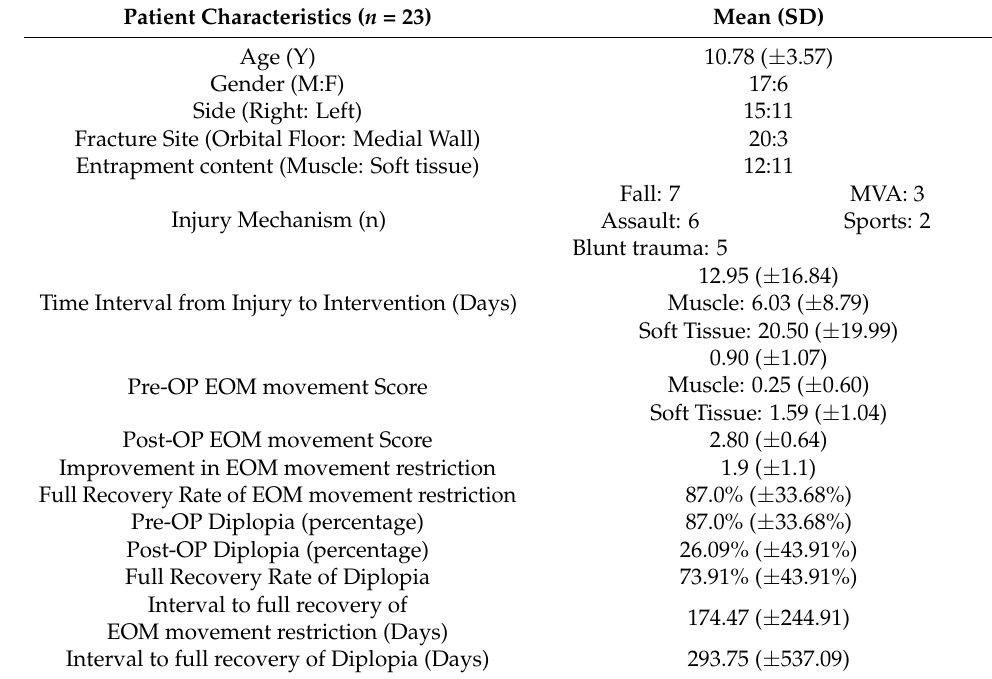
Table 2. Patient